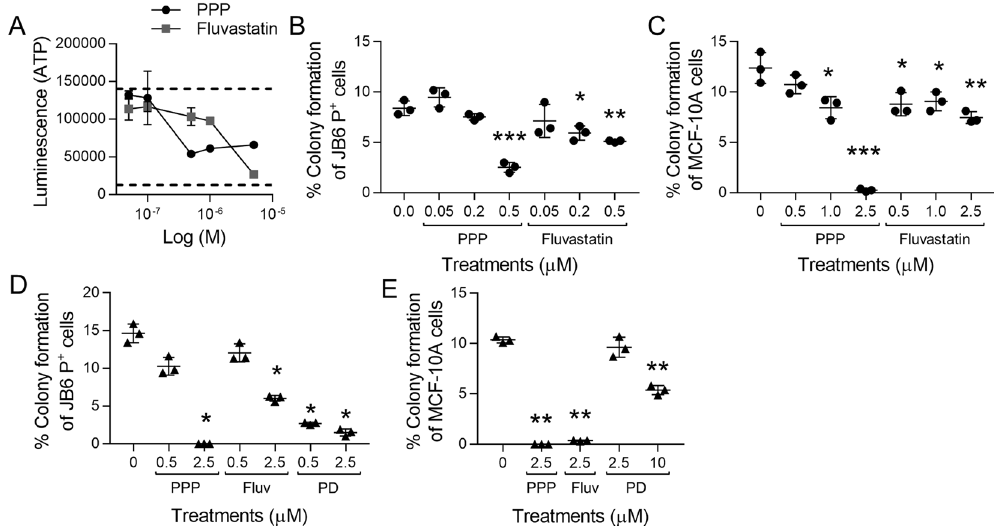
Figure 2. PPP and fluvastatin significantly attenuate FGF2-stimulated transformation of epithelial cells. ( A ) PPP and fluvastatin concentration-dependently inhibit JB6 P + cell growth in low attachment conditions. Dotted lines indicated FGF2 (top) and untreated controls (bottom). Each treatment had three technical replicates. JB6 P + cells were cultured with the optimized parameters. ( B ) PPP and fluvastatin attenuate FGF2 (0.5 ng/mL)- stimulated JB6 P + cell growth in soft agar at 0.5 µ M and 0.2 and 0.5 µ M respectively. The soft agar was performed as described in Materials/Methods with three technical replicates. ( C ) PPP and fluvastatin attenuates FGF2 (20 ng/mL)-stimulated MCF-10A cell growth in soft agar at 1.0 and 2.5 µ M and 0.5, 1.0, and 2.5 µ M respectively. The soft agar was performed as described in Materials/Methods with three technical replicates. ( D ) PPP and fluvastatin (Fluv) significantly attenuate MFTF (200 µ g/mL)-stimulated JB6 P + cell growth (1000 cells/well) in soft agar at 2.5 µ M and PD166866 (PD) was significant at 0.5 and 2.5 µ M. The soft agar was performed as described in Materials/Methods with three technical replicates. ( E ) PPP and fluvastatin (Fluv) significantly attenuate MFTF (200 µ g/mL)-stimulated MCF-10A cell growth (1000 cells/well) in soft agar at 2.5 µ M and PD166866 (PD) was significant at 10 µ M. The soft agar was performed as described in Materials/Methods with three technical replicates. The soft agar assays were analyzed by one-way ANOVA with multiple comparisons ( * p < 0.05; ** p < 0.01; *** p <